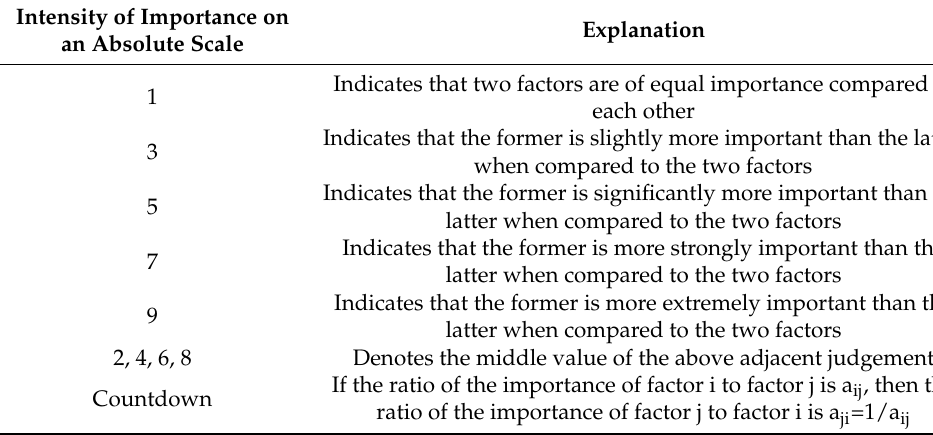
Table A4. The importance of factors in AHP.